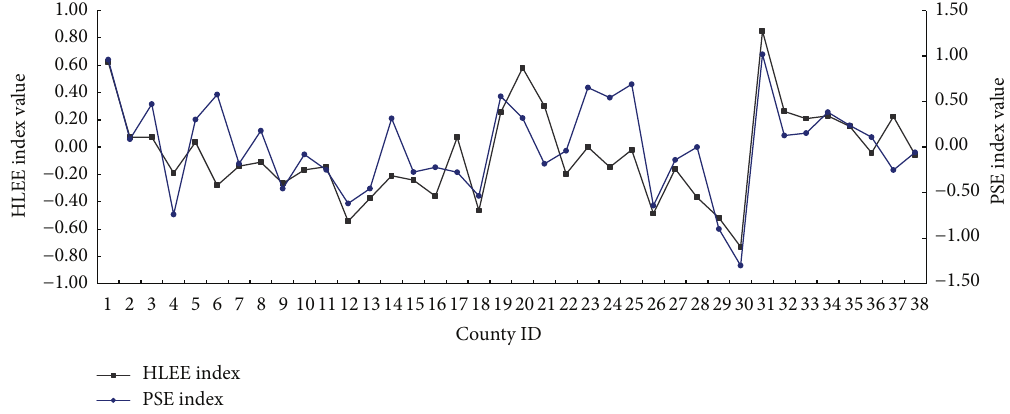
Figure 3: The curve of human living environmental evaluation (HLEE) index and public services evaluation (PSE) index (county ID is the same as it in Figure 2).